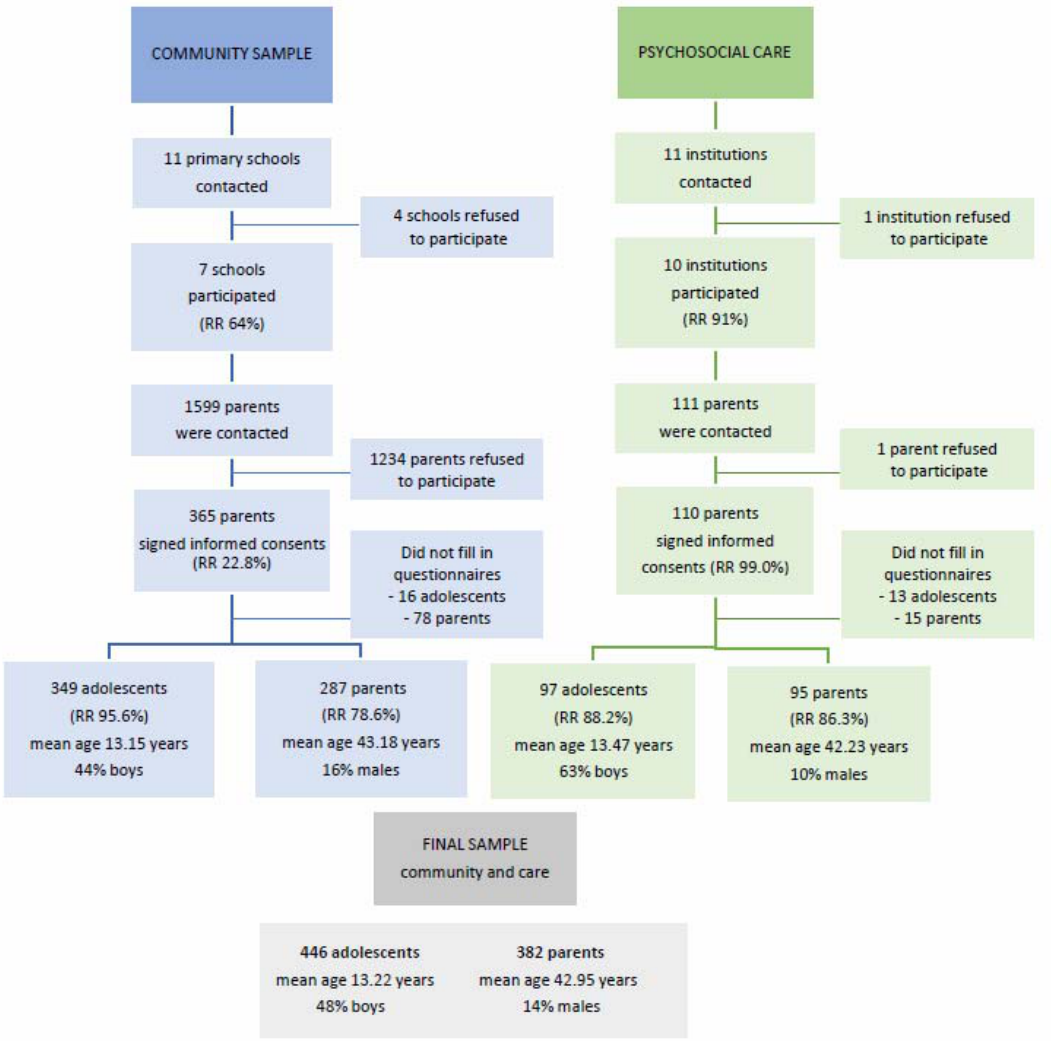
Figure 1. Flowchart outlining the process of recruitment of participants from the community and from psychosocial care services for the study, with basic descriptive information of the sample (RR—response rate).